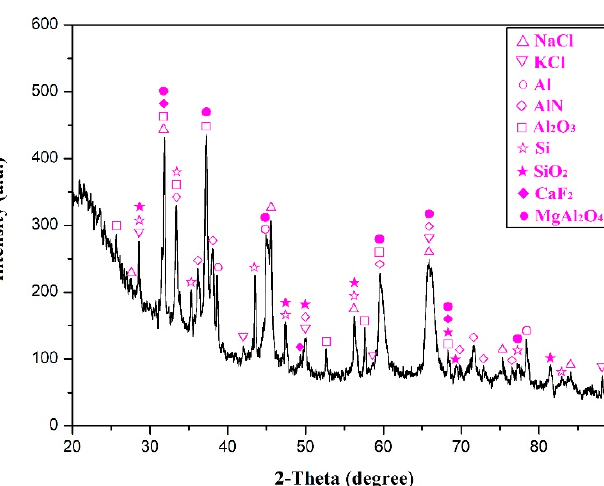
Figure 2. The XRD pattern of the as-received SAD.